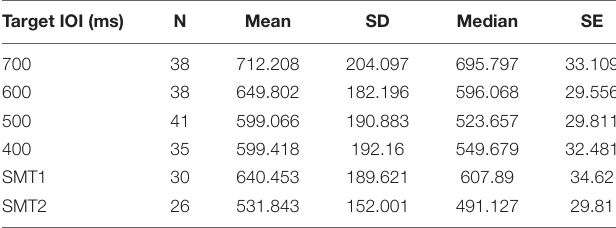
TABLE 1 | Inter-onset-interval (IOI) of infant drumming derived from FFT.